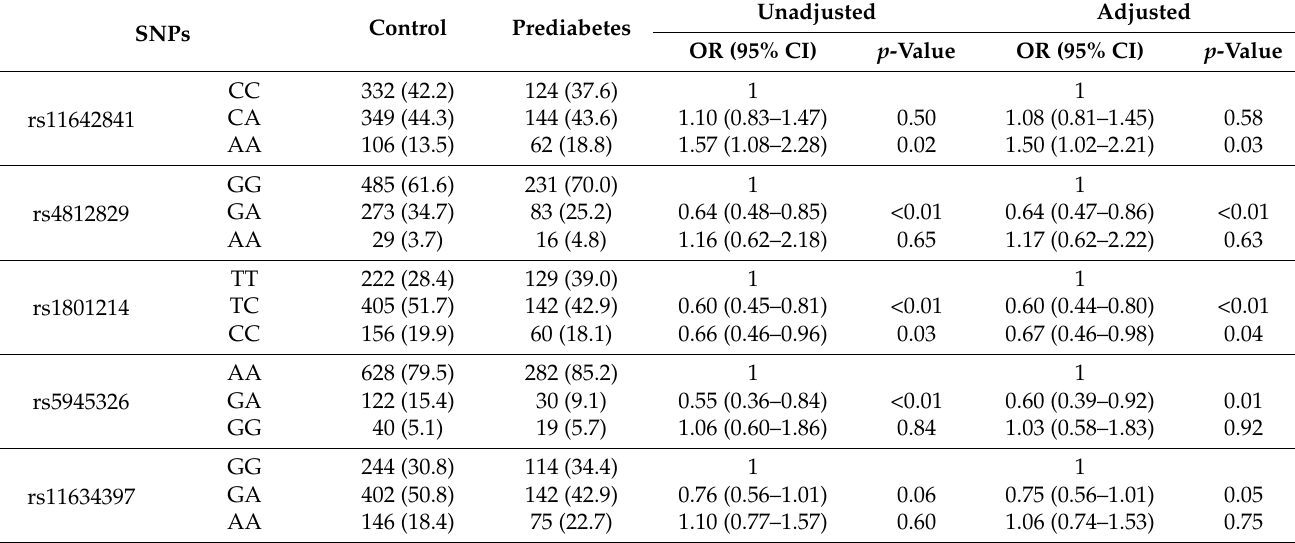
Table 2. Association between SNPs and prediabetes